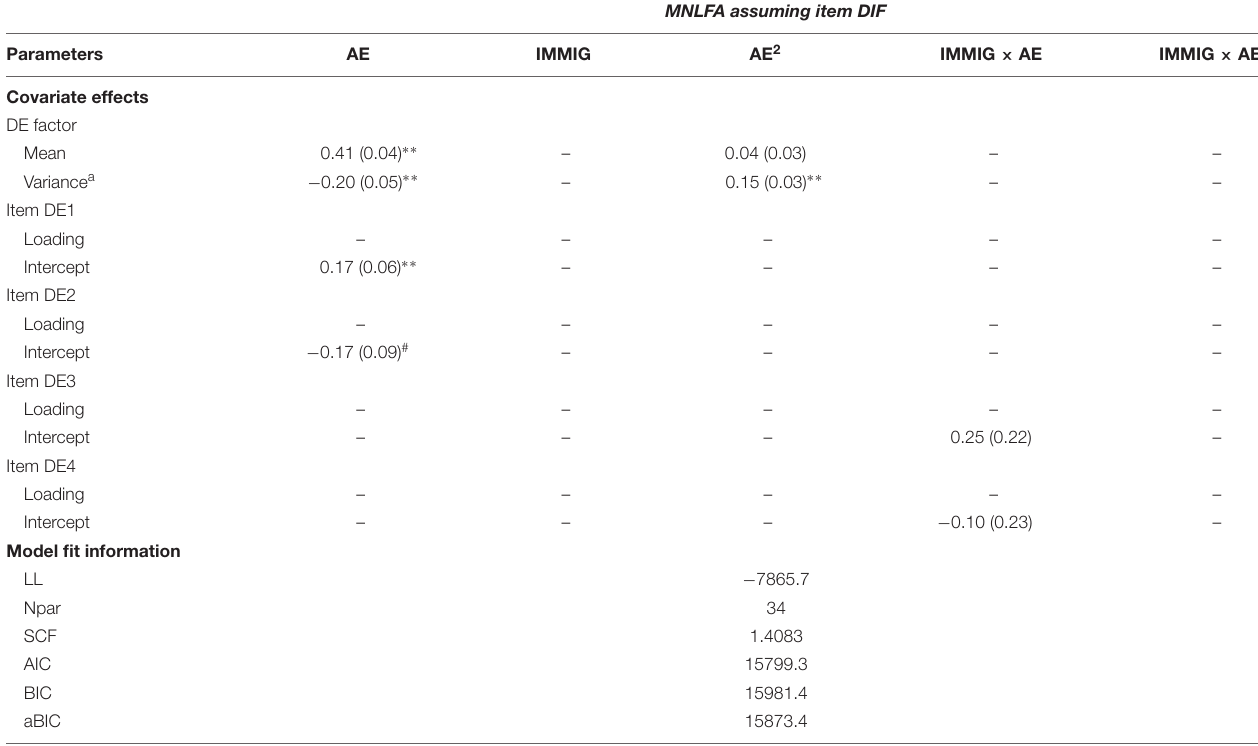
TABLE 5 | Unstandardized parameter estimates from the MNLFA models with affective-emotional adaptability , students’ immigration status, and their interaction as covariates.